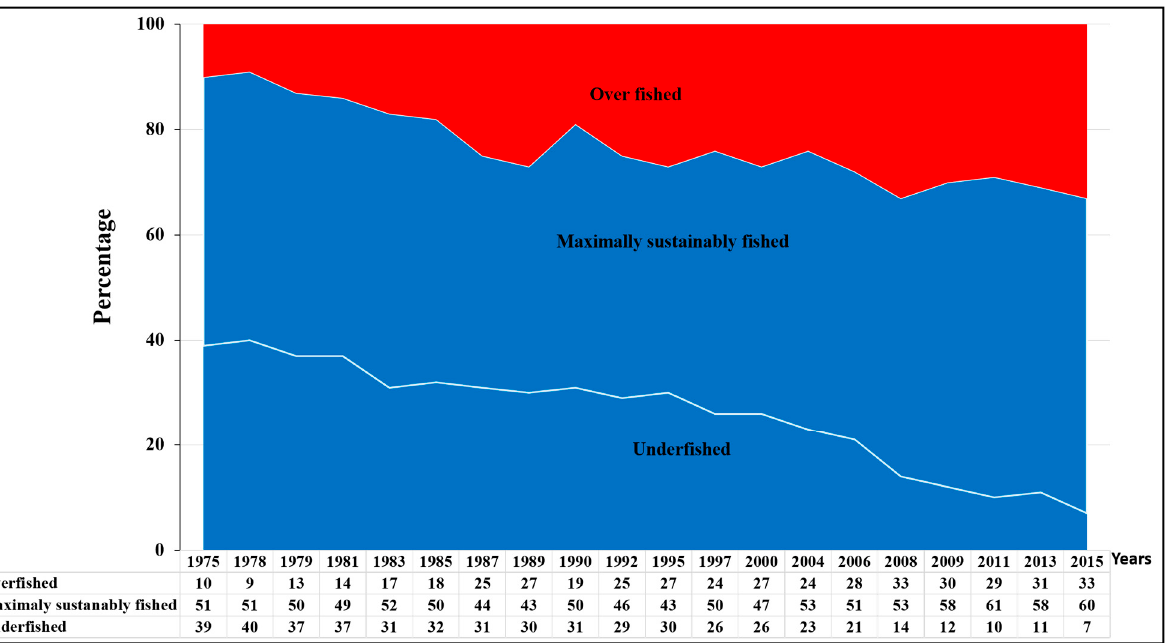
Figure 3. The trend of the global marine fish stock (source: [3]).